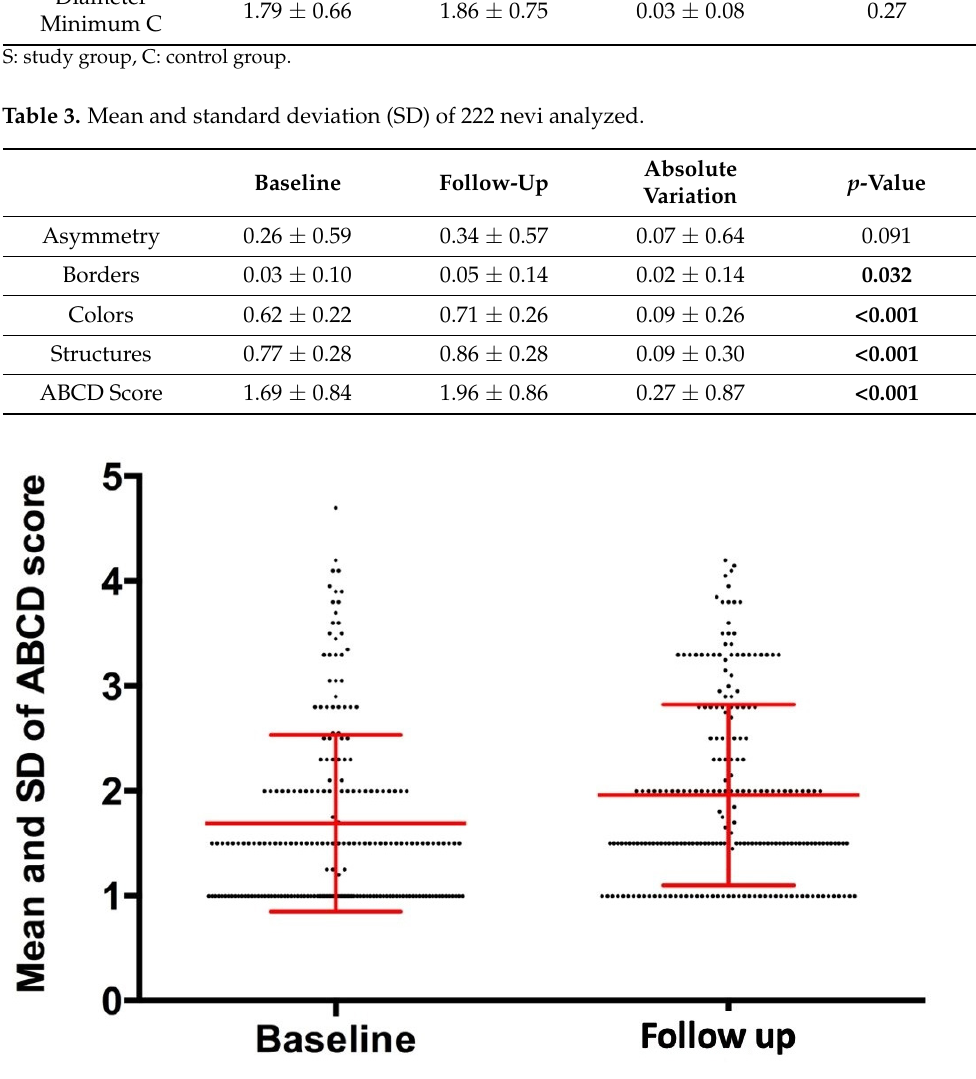
Table 4. Correlation coefficients between variations in the auxological with respect to the mor ‐ phological parameters.